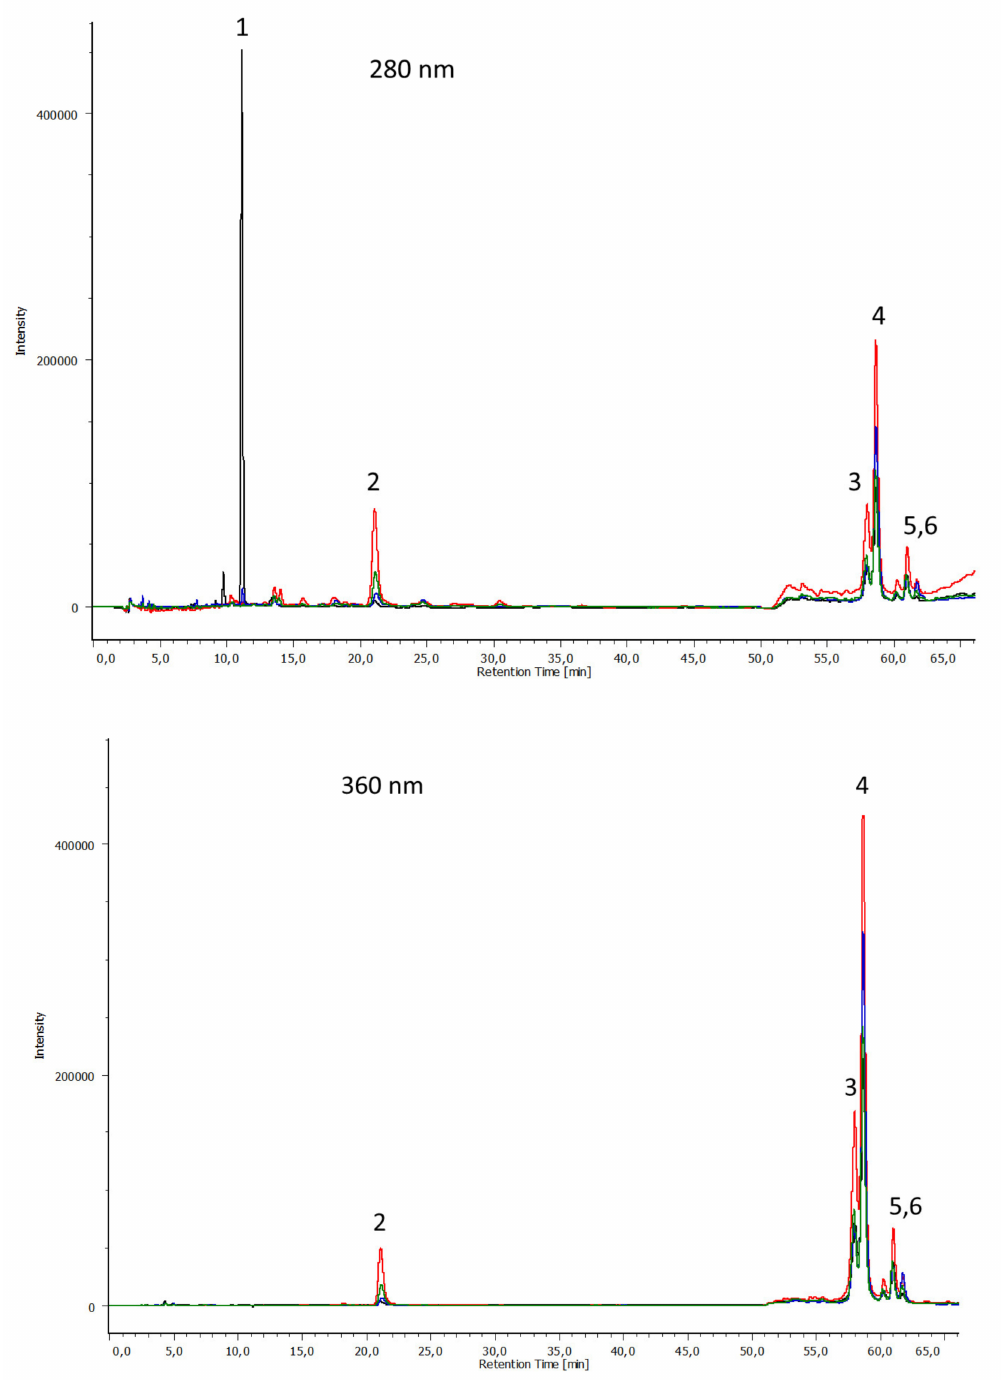
Figure 3. HPLC profile of leaf extract of Aglianico of October (black line), Aglianico of November (red line), Greco di Tufo of October (blue line), and Greco di Tufo of November (green line) at 280 NM and 360 NM. 1 = gallic acid, 2 = vanillic acid, 3–4 = quercetin derivatives, 5–6 = Kaempferol